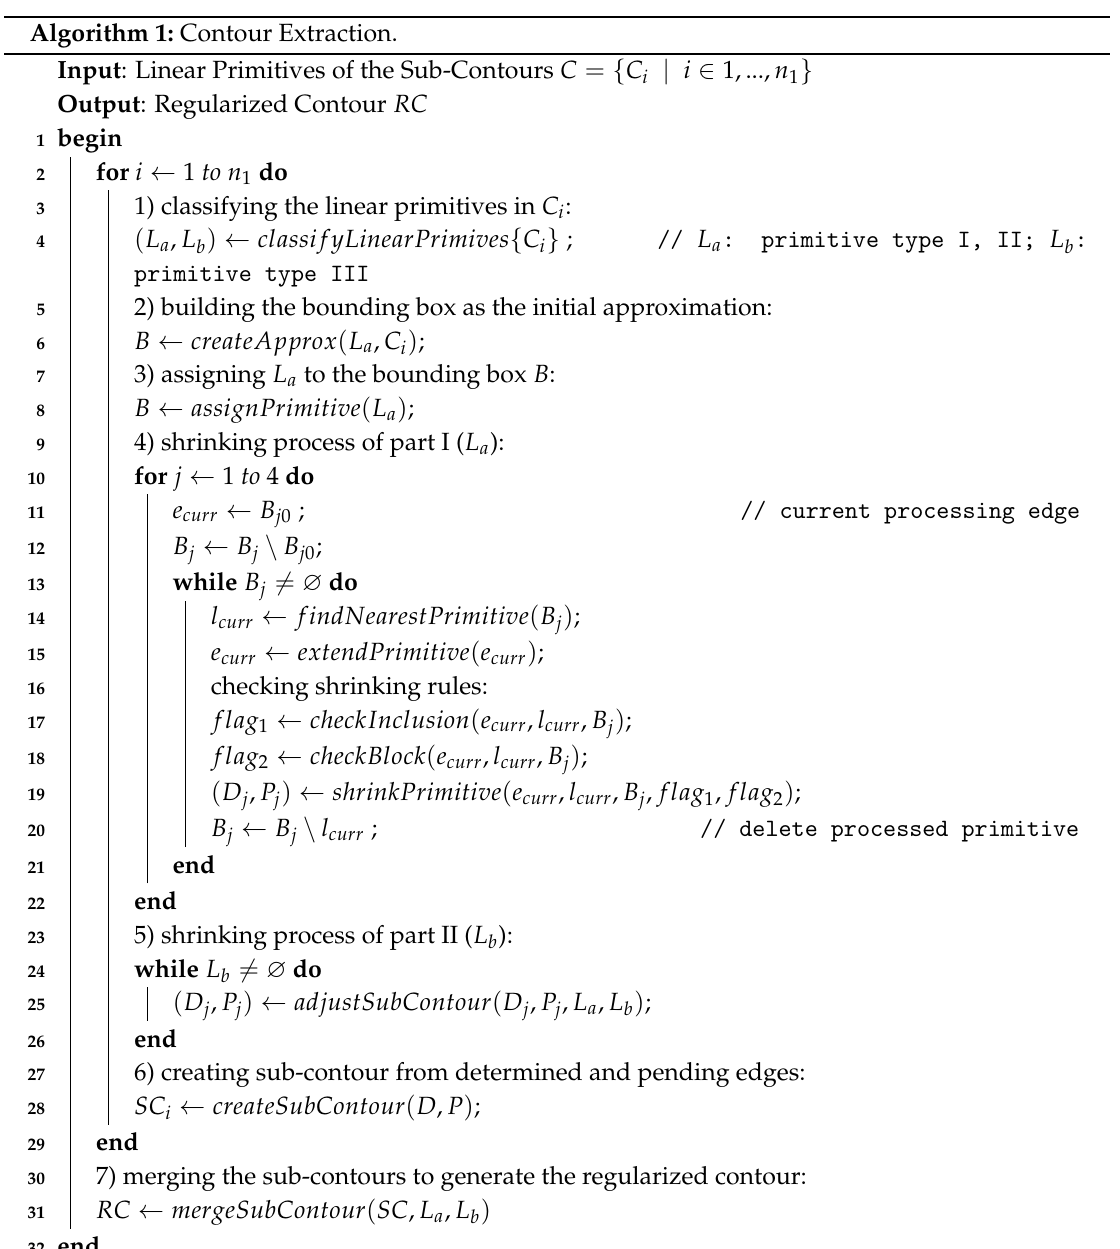
Algorithm 1: Contour